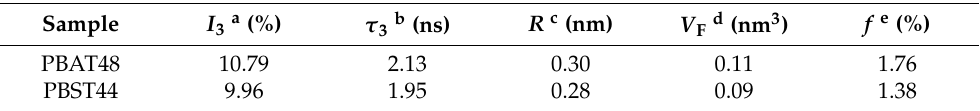
Table 5. Positron annihilation lifetime spectroscopy (PALS) results related to free volume of PBAT48 and